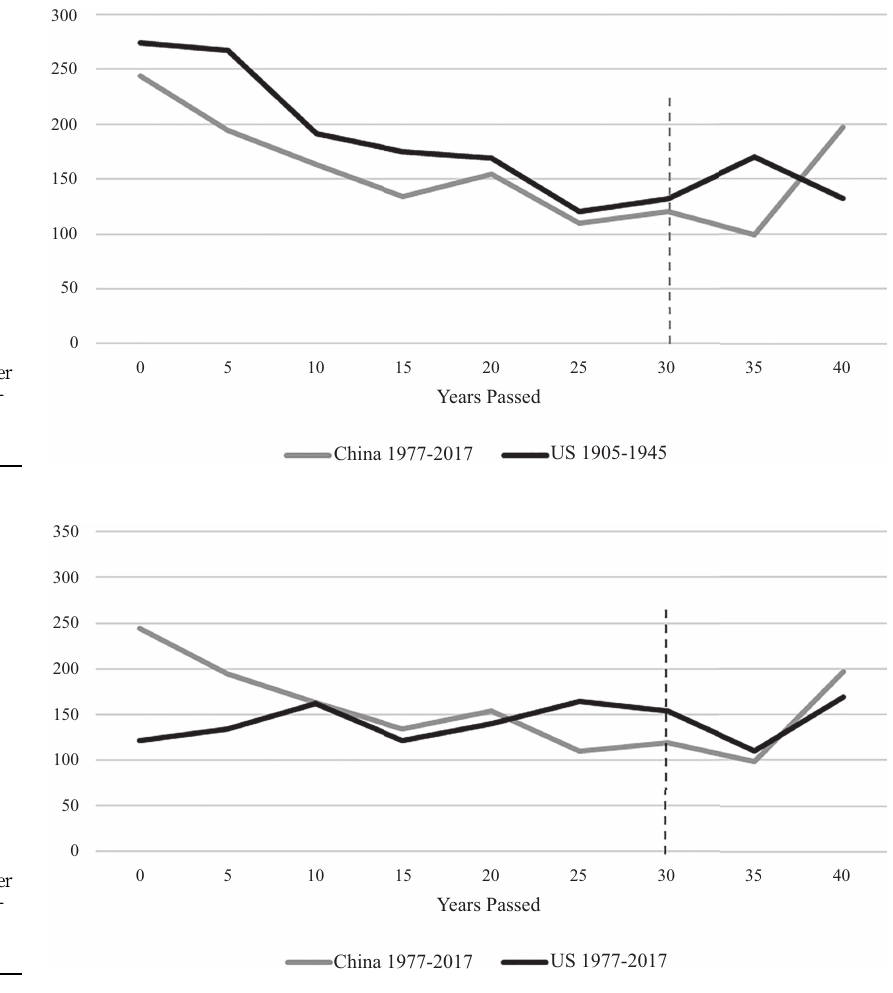
Figure 7. National identity over